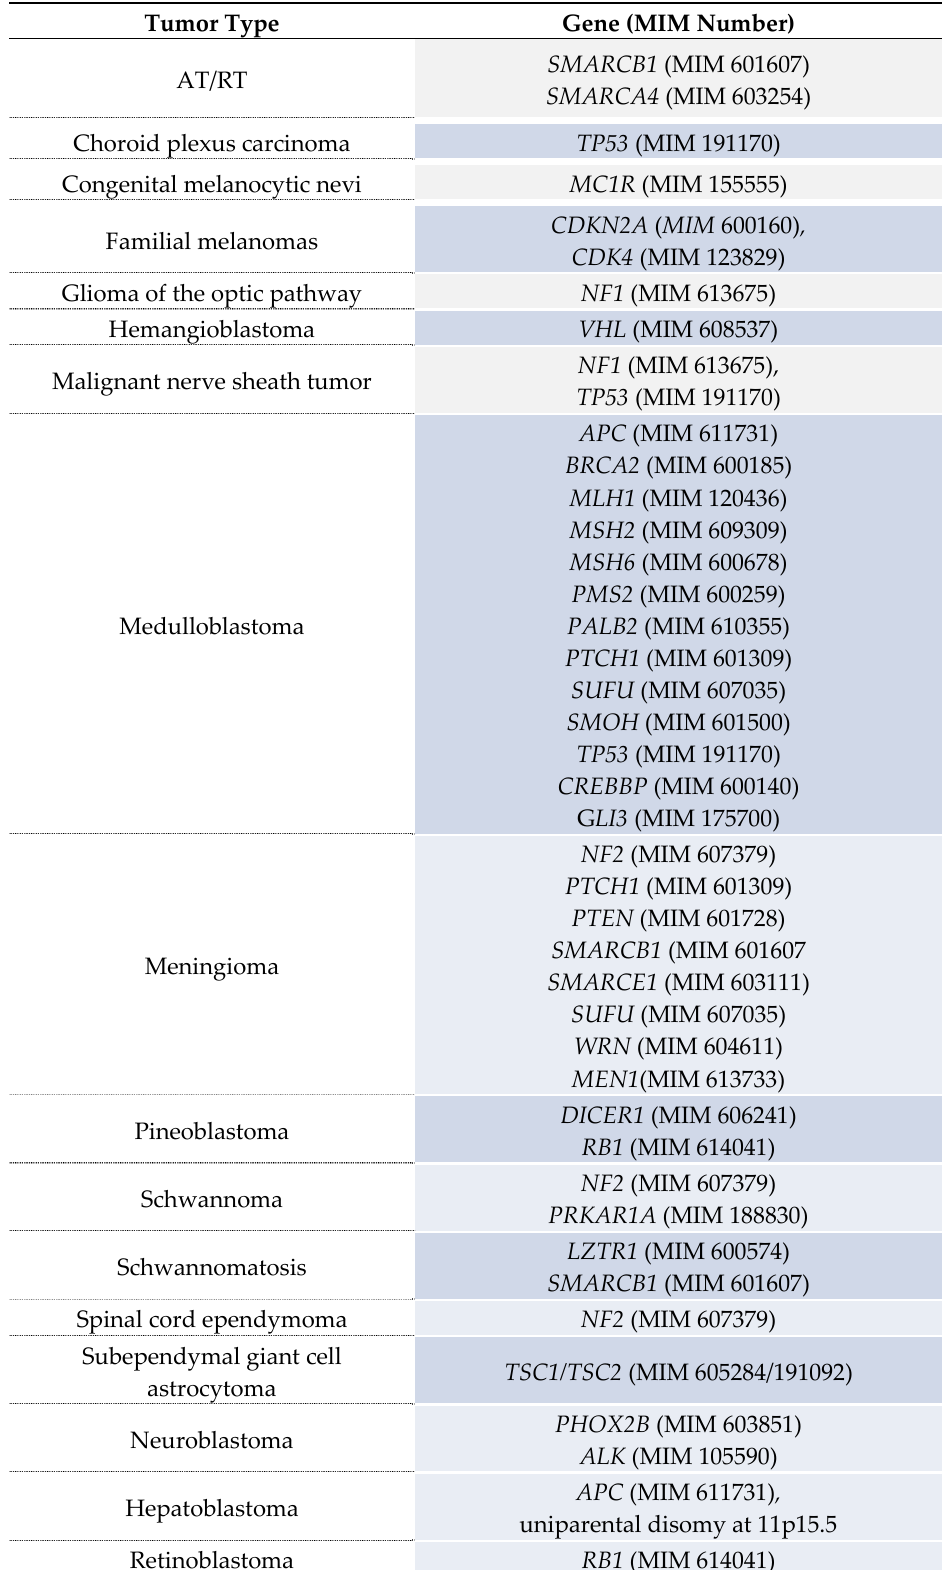
Table 12. Germline alterations in selected solid tumors in children.